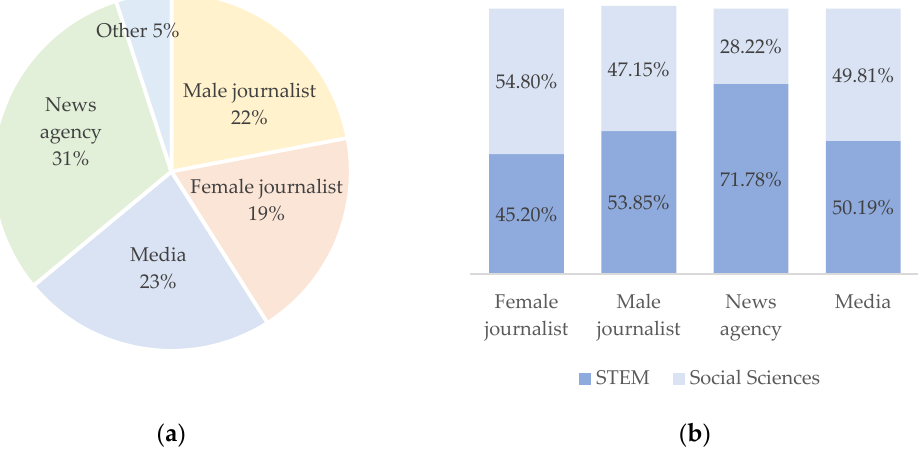
Figure 2. ( a ) Authorship of content ( b ) Percentage of knowledge areas according to authorship.